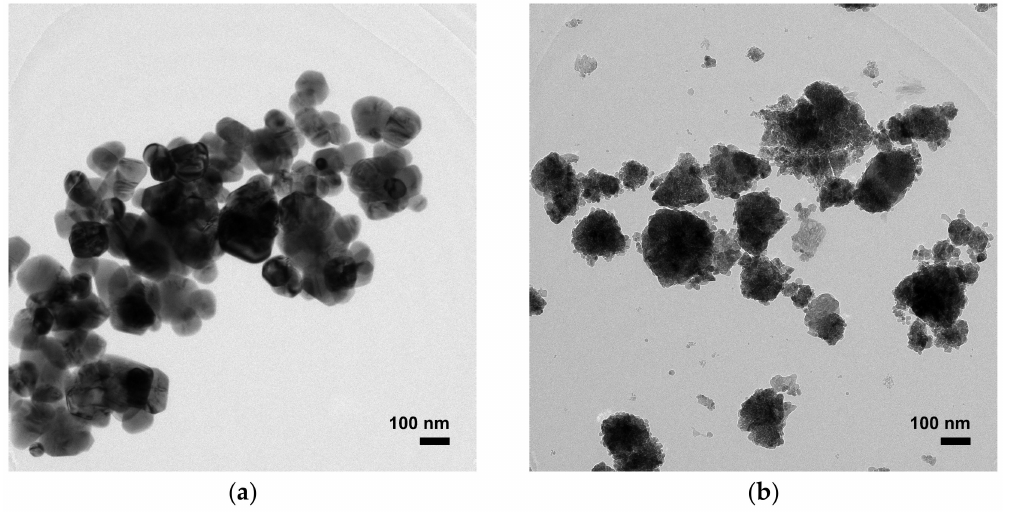
Figure 3. TEM microstructural images of ZnO prepared by ( a ) precipitation and ( b )